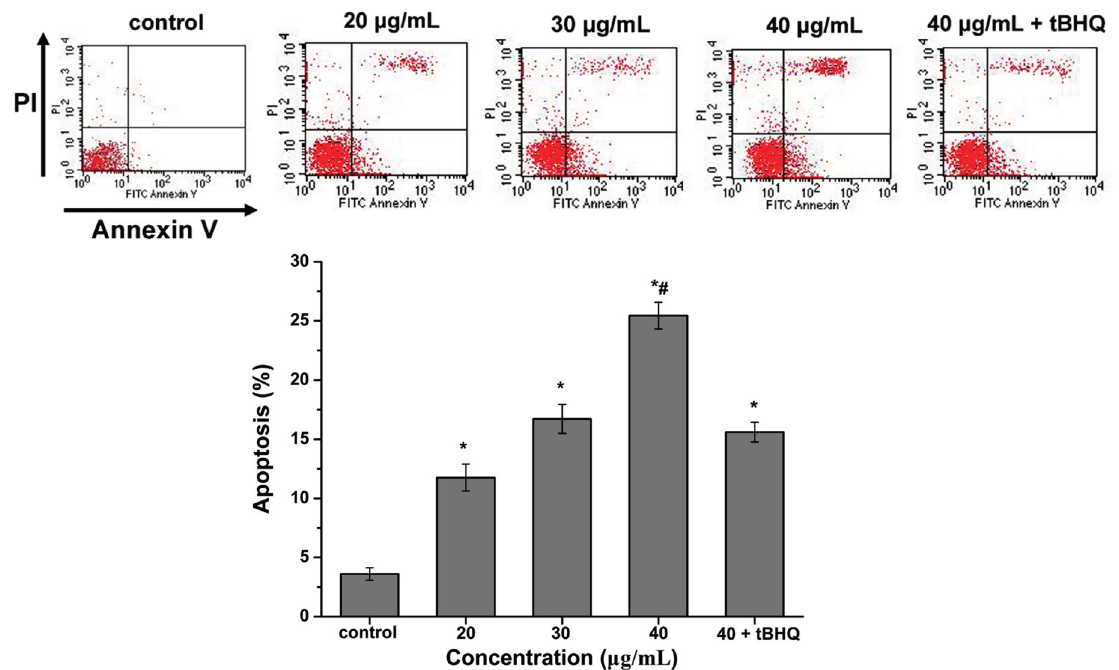
Figure 5. Flow cytometric evaluation of the effect of CdTe QDs on AML12 cells apoptosis and necrosis after 24 h of treatment with 20, 30, 40 μ g/mL CdTe QDs and (40 μ g/mL CdTe QDs + tBHQ). Cells were stained using apoptotic detection kit (PI/annexin